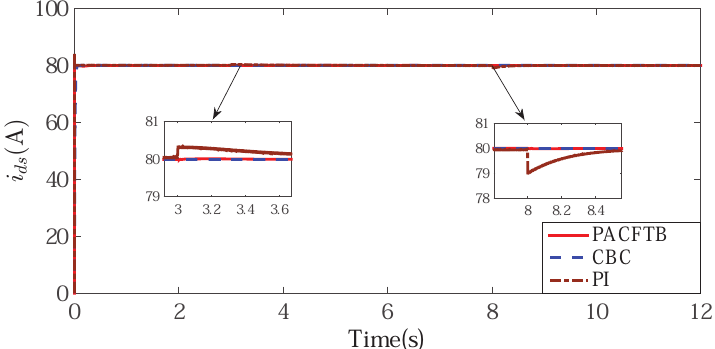
Figure 6. The output of d-axis control